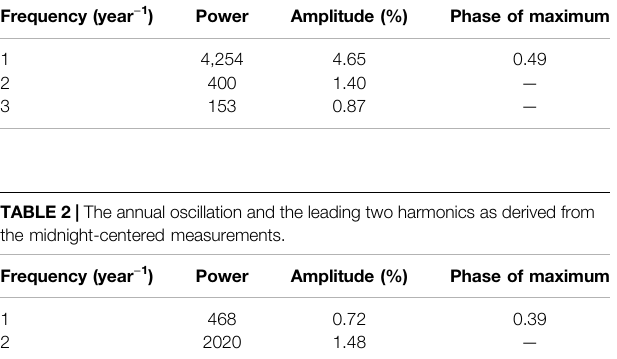
TABLE 1 | The annual oscillation and the leading two harmonics as derived from the GSI noon-centered measurements.